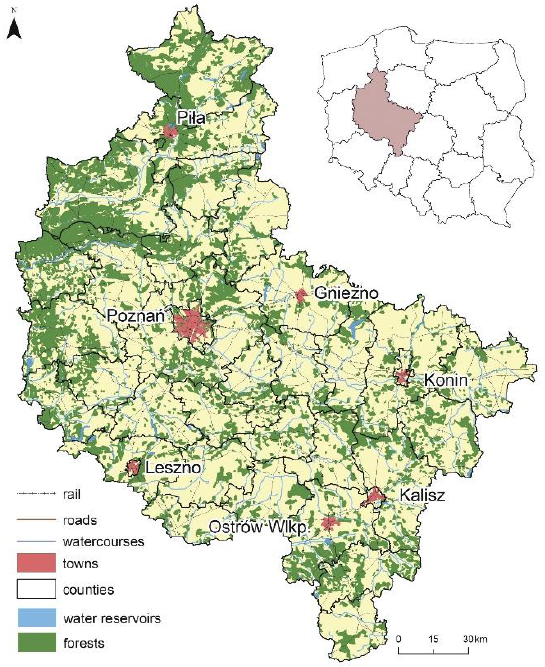
Figure 2. The physico-geographical map of the Greater Poland Voivodeship—watercourses and reservoirs (own study).